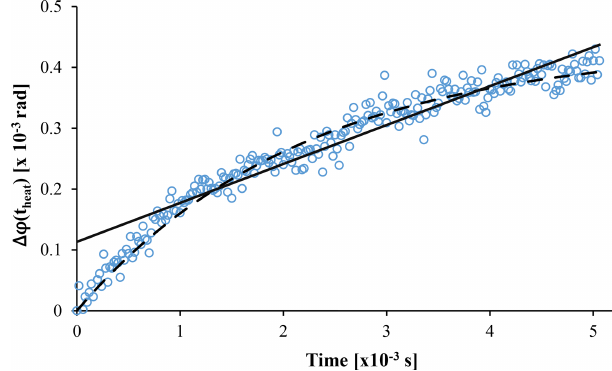
Figure 5. Measured phase shift during the heating phase averaged over a 1s interval for a strongly absorbing aerosol (approximately 100µgm − 3 eBC) in Ar. The black dashed line represents the best least squares exponential fit, while the solid line is the linear fit to the